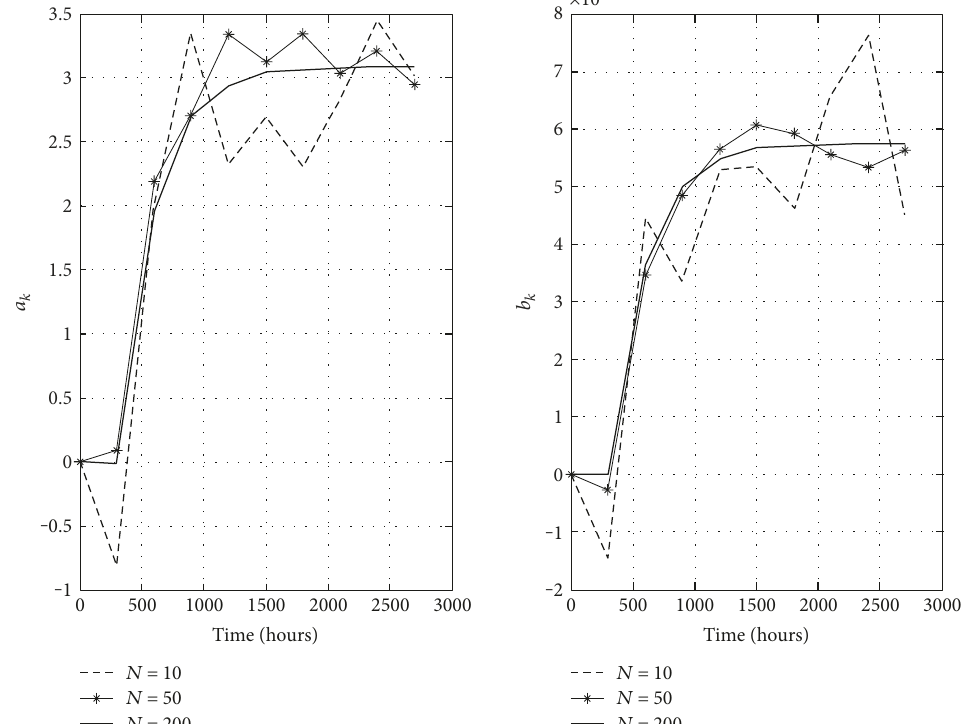
Figure 3: The member ’ s number in fl uence on the parameter convergence.